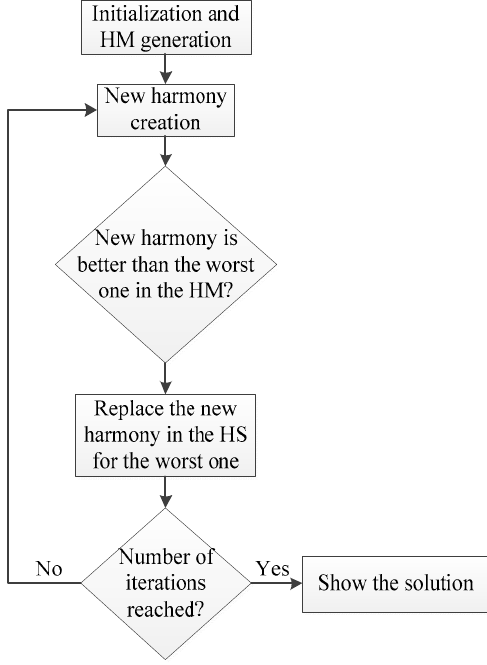
Figure 4. Harmony Search flowchart of the basic steps.